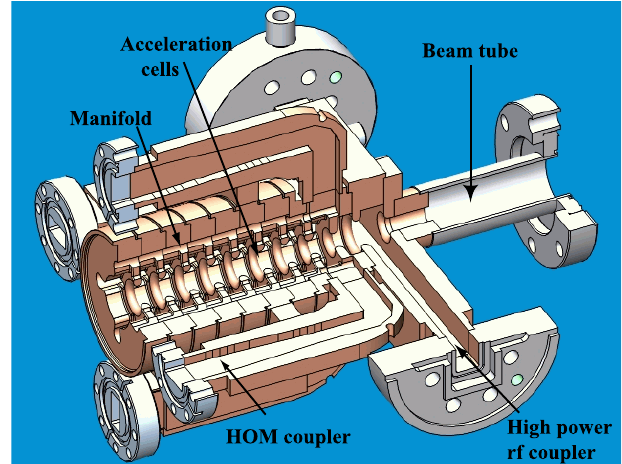
FIG. 1. (Color) CAD drawing illustrating a cross-sectional view of the output region of H60VG4SL17A through slots present in almost all of the 55 cells of the structure. The Q associated with this damping is approximately 500 and we refer to this as a medium damped structure (in contradistinction to, for example, the CLIC structure, which is heavily damped with a Q (cid:1) 10